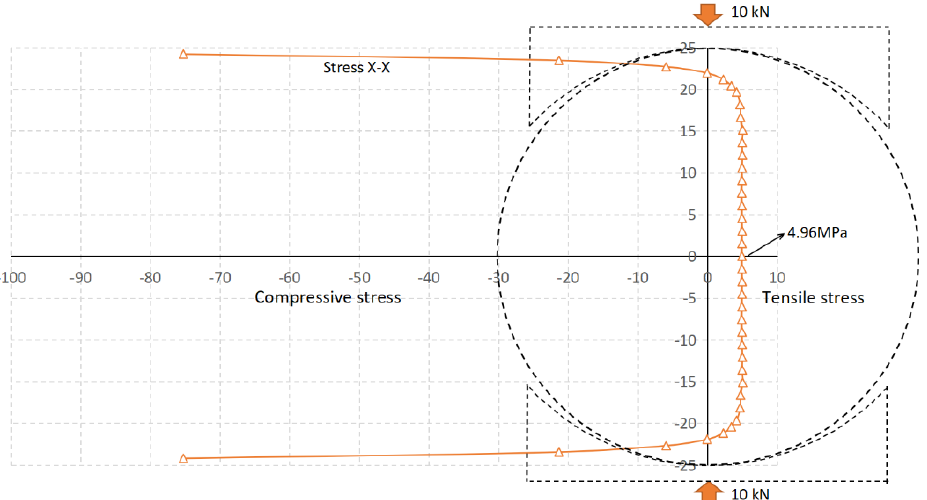
Figure 14. The stress X − X distribution in the monitoring line for Type III testing under external load of 10 kN.